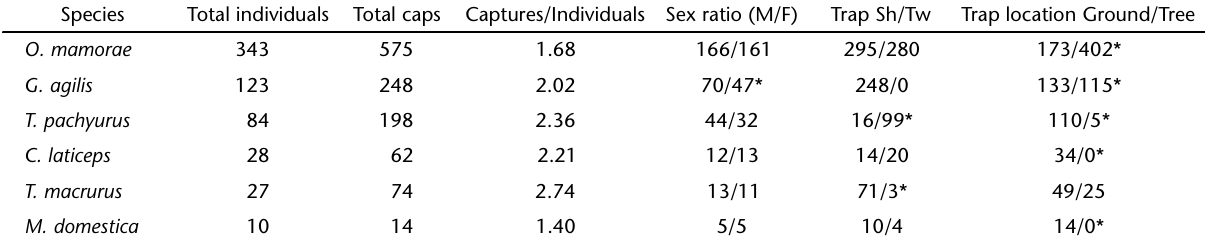
Table II. Total number of individuals, captures, mean number of captures per individual, number of males and females captured, number of captures per trap type, and location (ground/tree) of each species recorded in the Rio Negro farm, Aquidauana, from February 2003 to November 2004. (Sh) Sherman, (Tw) Tomahawk, (Caps) captures. Species Total individuals Total caps Captures/Individuals Sex ratio (M/F) Trap Sh/Tw